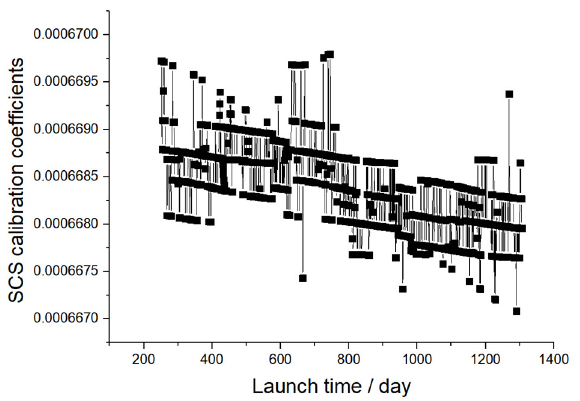
Figure 11. Remainder components and 3 σ criterion line to determine outliers. ( a ) Shows the remainder component and its corresponding 3 σ criterion lines using the entire calibration coefficients and ( b ) shows the remainder component and its corresponding 3 σ criterion lines using the calibration coefficients data without the first 250 days.